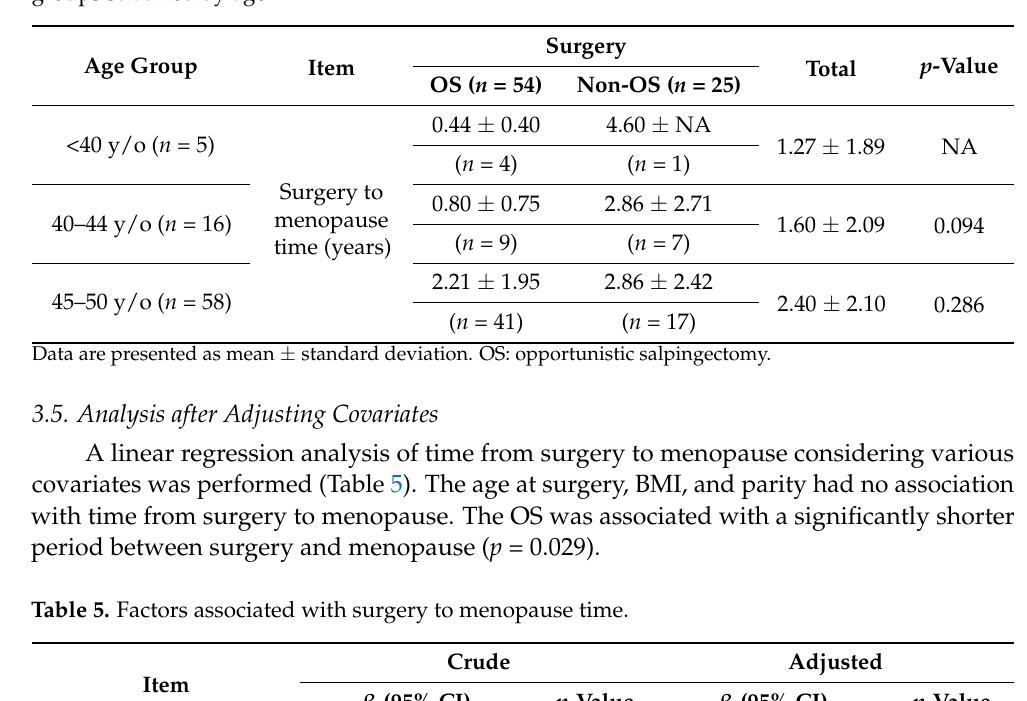
Table 4. Comparison of the length of time from surgery to menopause between the different surgery groups stratified by age.